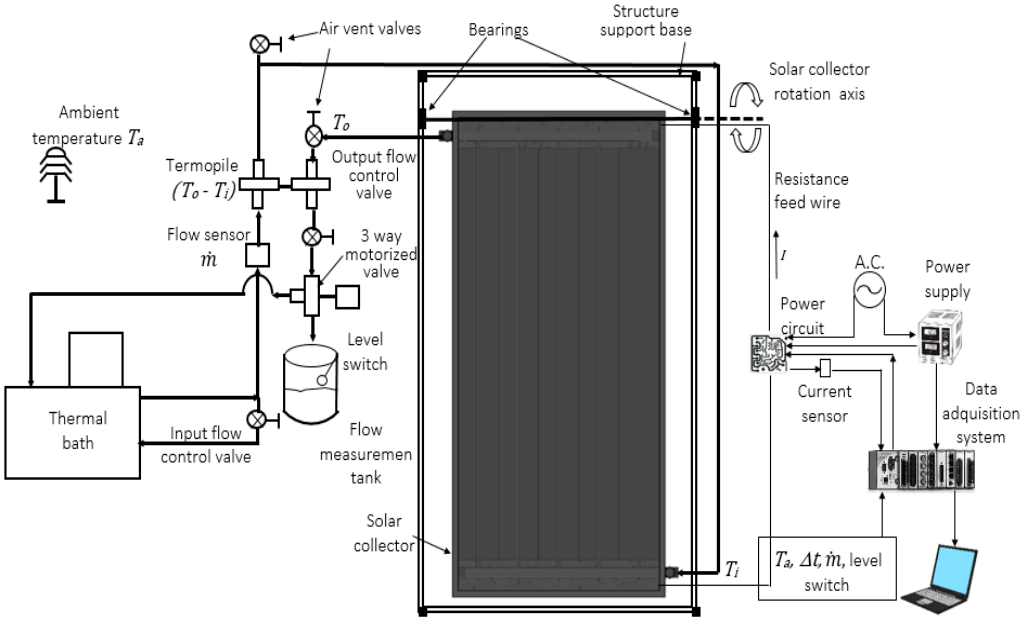
Figure 4. Experimental setup.